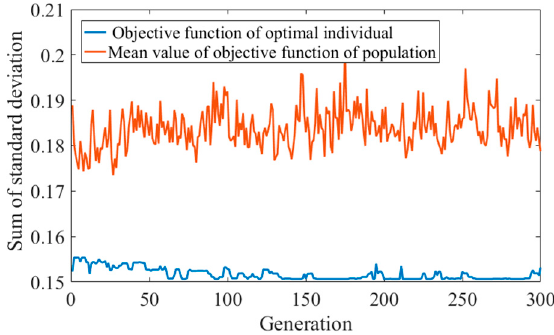
Figure 10. The sum of standard deviation varies with genetic generation.